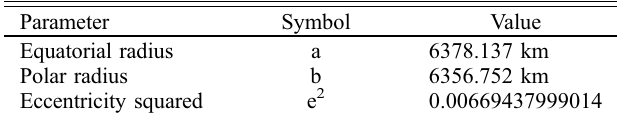
Table 1. Parameters of the WGS84 Earth